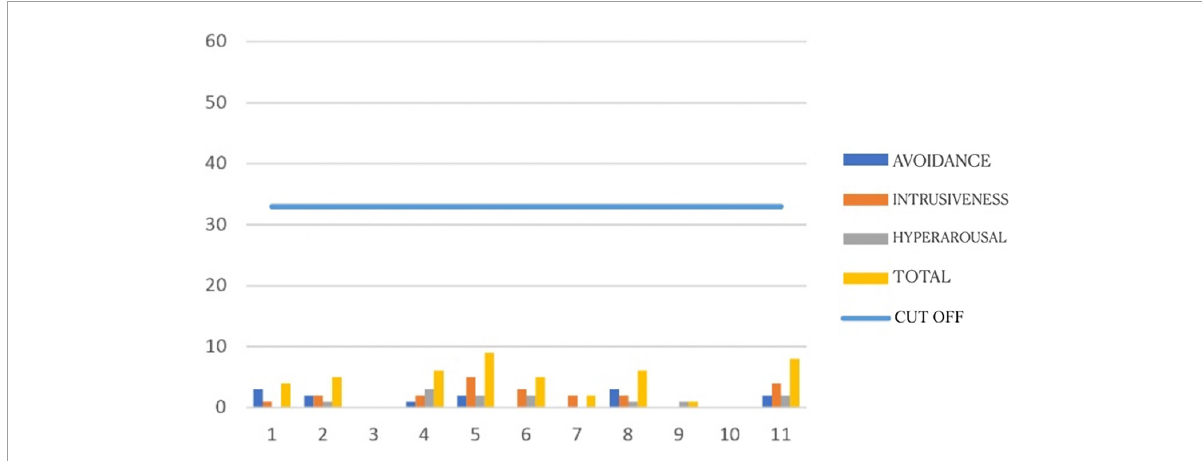
FIGURE2 Post-intervention Impact of Event Scale-Revised (IES-R) scores for each participant.